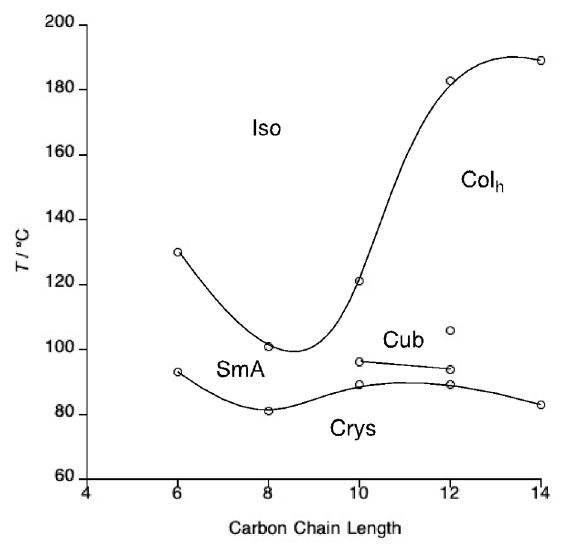
Figure 2. Phase diagram of the tetracatenar N -phenylpyridinium octyl sulfate salts, 3 - n .